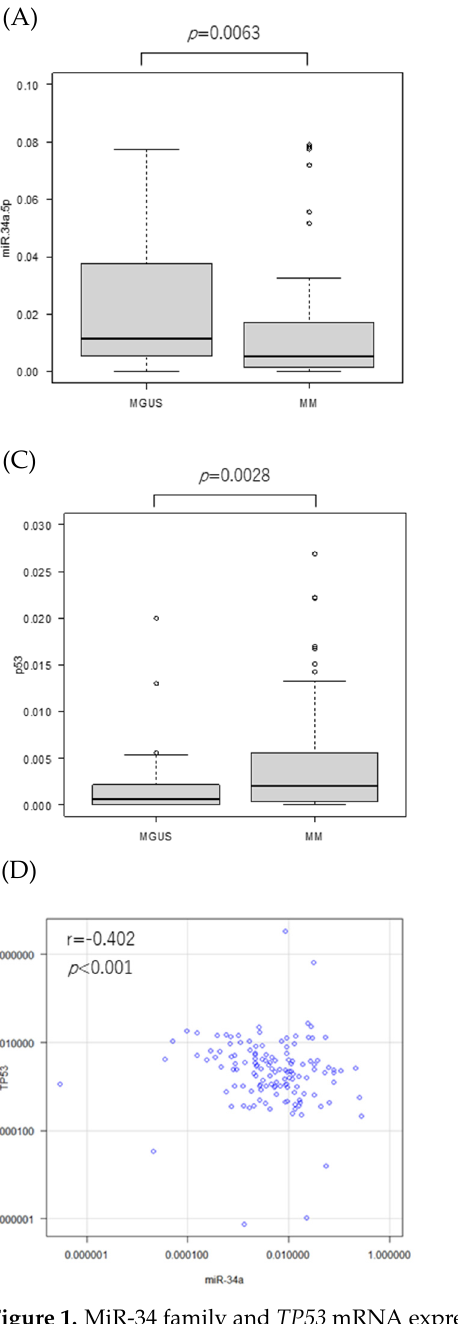
Figure 1. MiR-34 family and TP53 mRNA expressions. Box plots show each transcript’s expression. Y axis indicates delta-delta Ct value. Outliers are excluded from the plots. ( A ) miR-34a, ( B ) miR-34b, ( C ) TP53 . Correlations between miR-34 and TP53 expressions. ( D ) miR34a- TP53 , ( E ) miR-34b- TP53 . Each dot represents an individual patient.